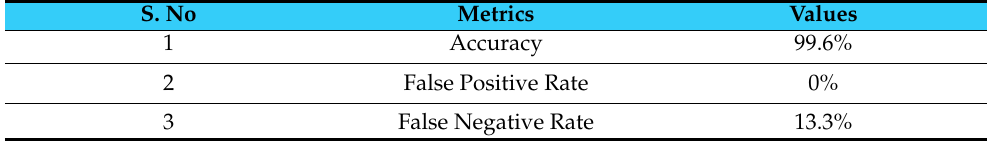
Table 4. Performance Evaluation of Proposed